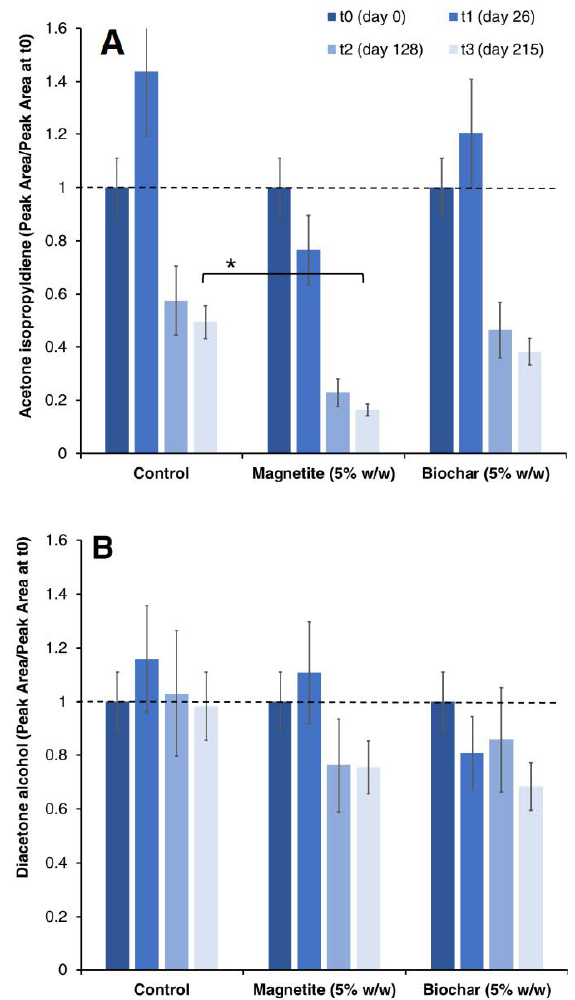
Figure 4. The relative concentration of acetone isopropylidene ( A ) and diacetone alcohol ( B ) over time in the different treatments. Error bars represent the standard error of replicated samples. Significant differences were determined by two-tailed Student’s t -tests (* corresponds to p < 0.05).